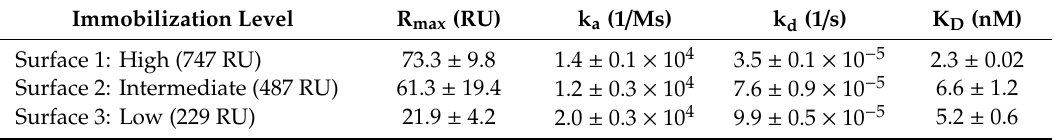
Table 1. Results from the kinetic analysis of the interaction between mTfR and scFv8D3-Z SYM73